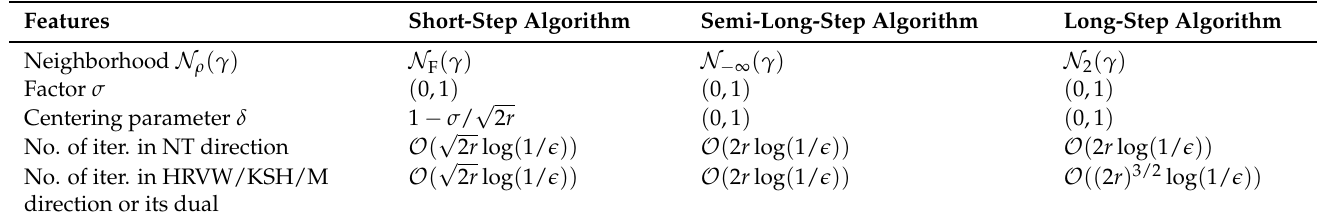
Table 2. Contrasting some features of path-following IPMs in short, semi-long, and long-step versions.